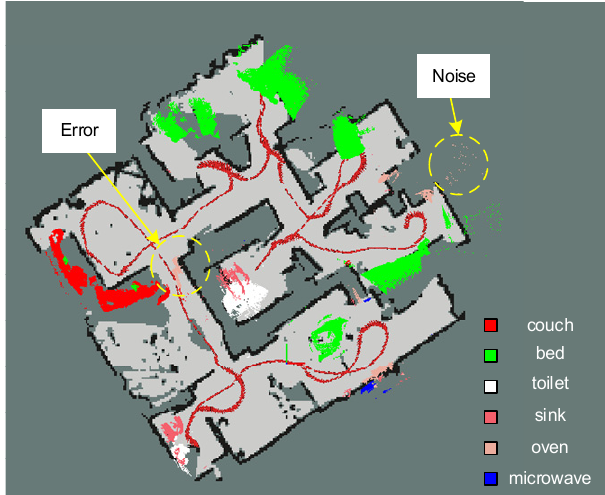
Figure 5. The generated object semantic point cloud.